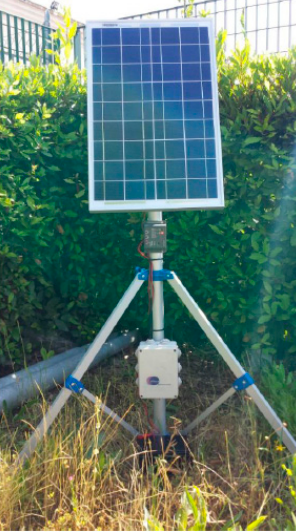
Figure 29. One of the nodes (enclosed in the white box) with its solar panel.